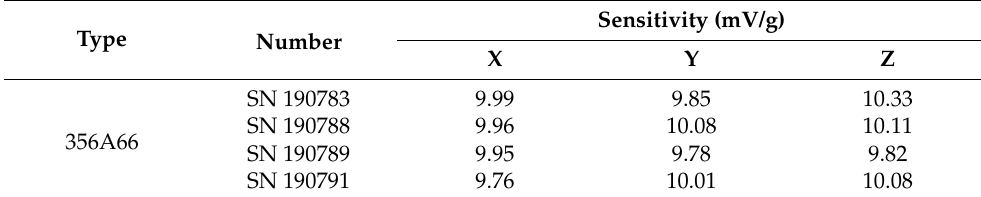
Figure 5. Dynamic measurement of the ball screw feed system. Table 2. Detailed parameters of the acceleration sensors.